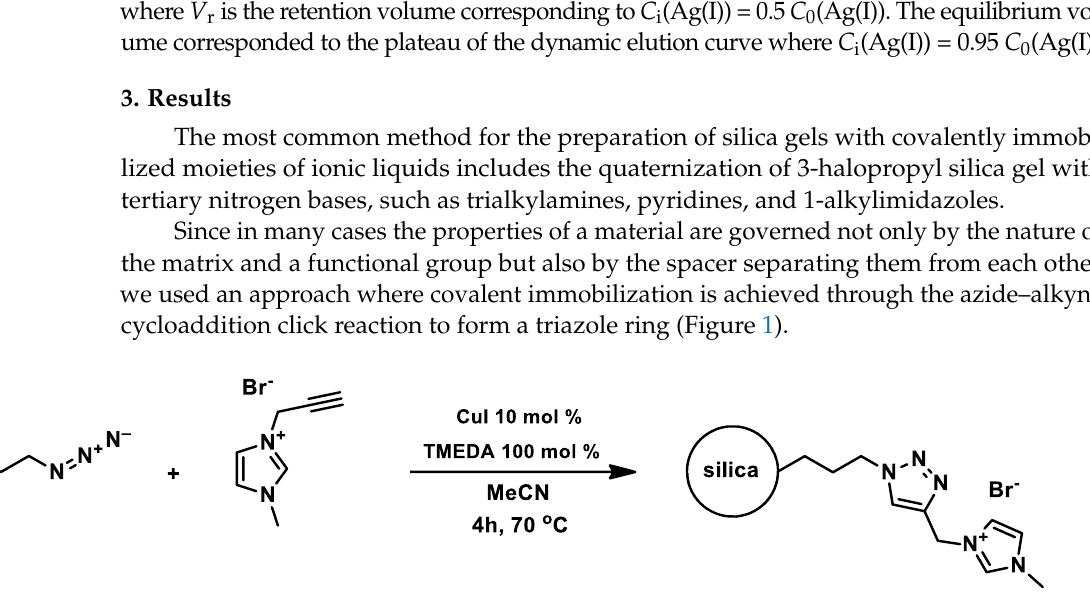
Figure 1. Synthesis of imidazolium – modified silica gel, Sil – Im.